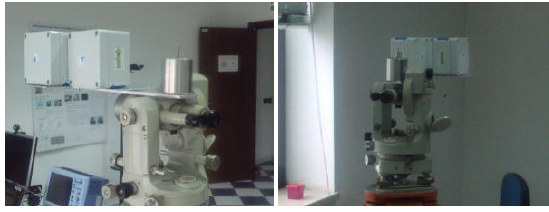
Figure 2. Sensors in the ” z_ up” e “z_ down”